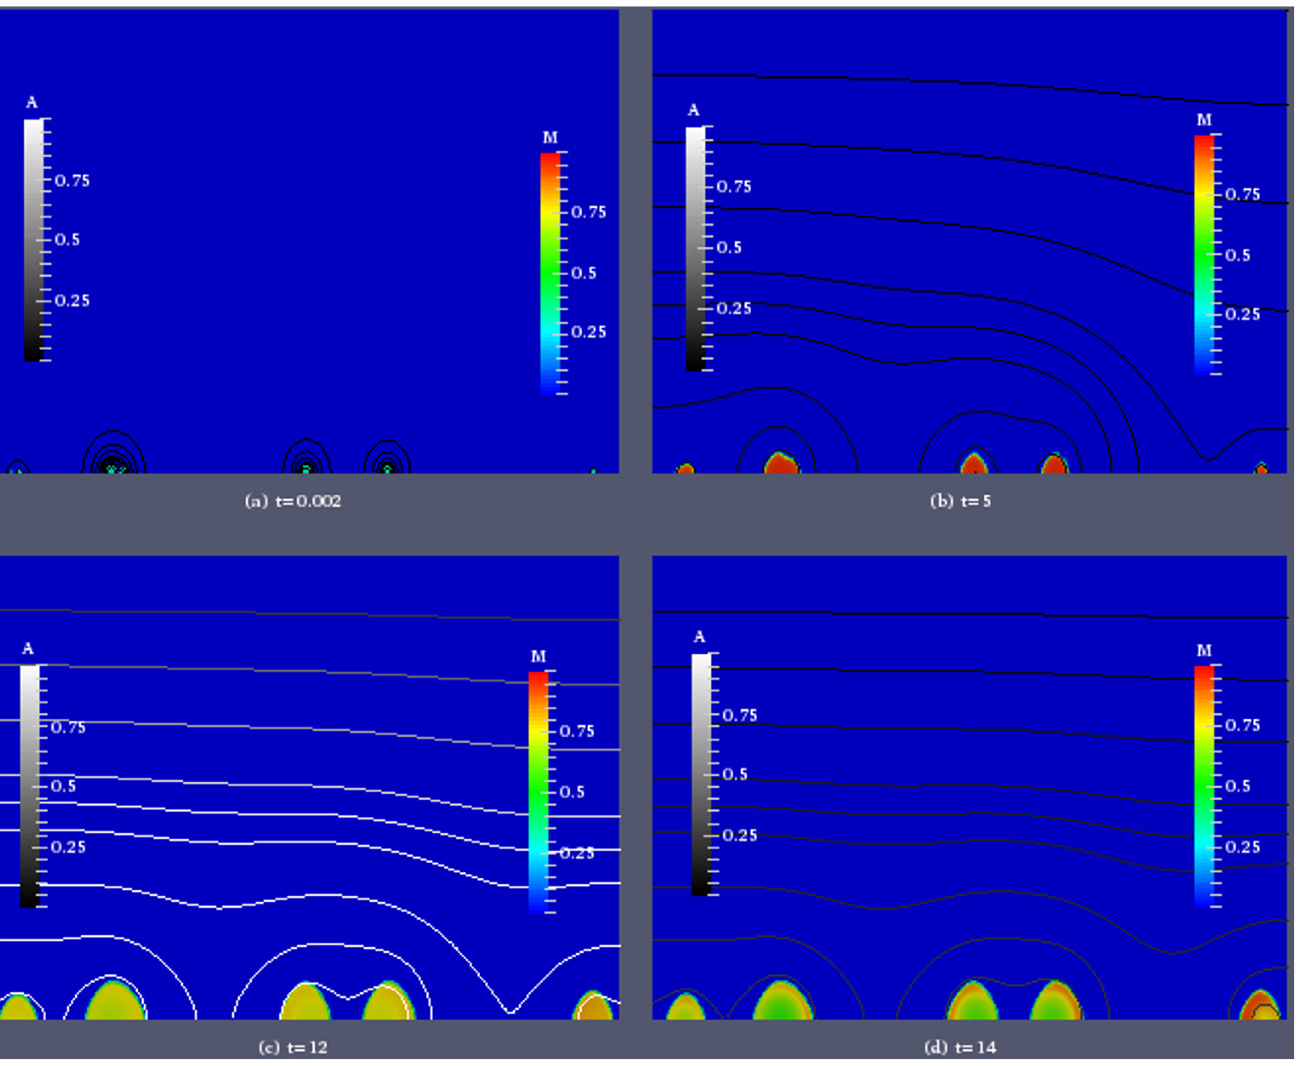
Fig 6. Simulation of biofilm growth for induction threshold τ = 20 nM and maximum dispersal rate η 1 = 3.6 d − 1 . Color coded is the biomass density M , iso-lines of the autoinducer concentration A are plotted in